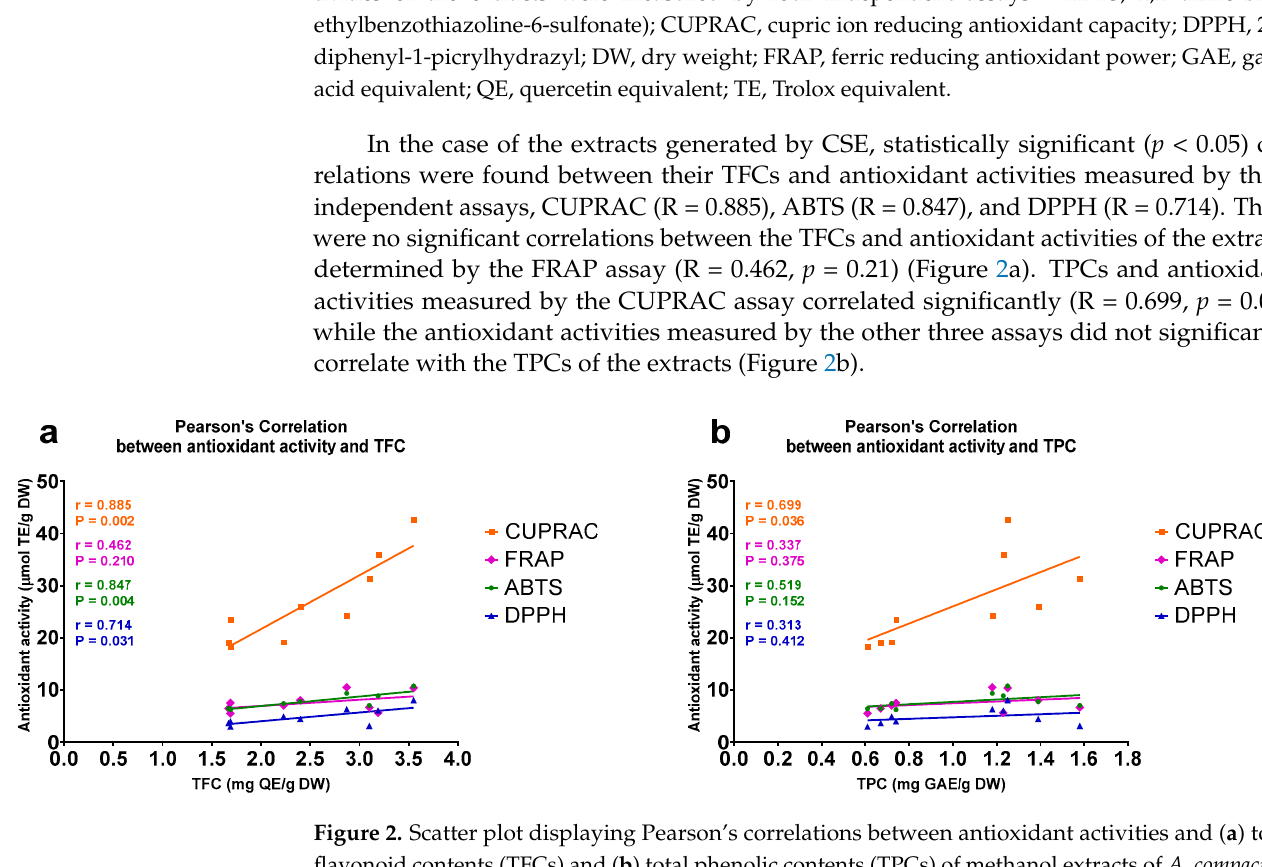
Figure 2. Scatter plot displaying Pearson’s correlations between antioxidant activities and ( a ) total flavonoid contents (TFCs) and ( b ) total phenolic contents (TPCs) of methanol extracts of A. compactum that were generated by continuous shaking extraction (CSE). The antioxidant activities of the extracts were measured by four independent assays. ABTS, 2,2 (cid:48) -azino-bis(3-ethylbenzothiazoline-6-sulfonate); CUPRAC, cupric ion reducing antioxidant capacity; DPPH, 2,2 (cid:48) -diphenyl-1-picrylhydrazyl; DW, dry weight; FRAP, ferric reducing antioxidant power; GAE, gallic acid equivalent; QE, quercetin equivalent; TE, Trolox equivalent.